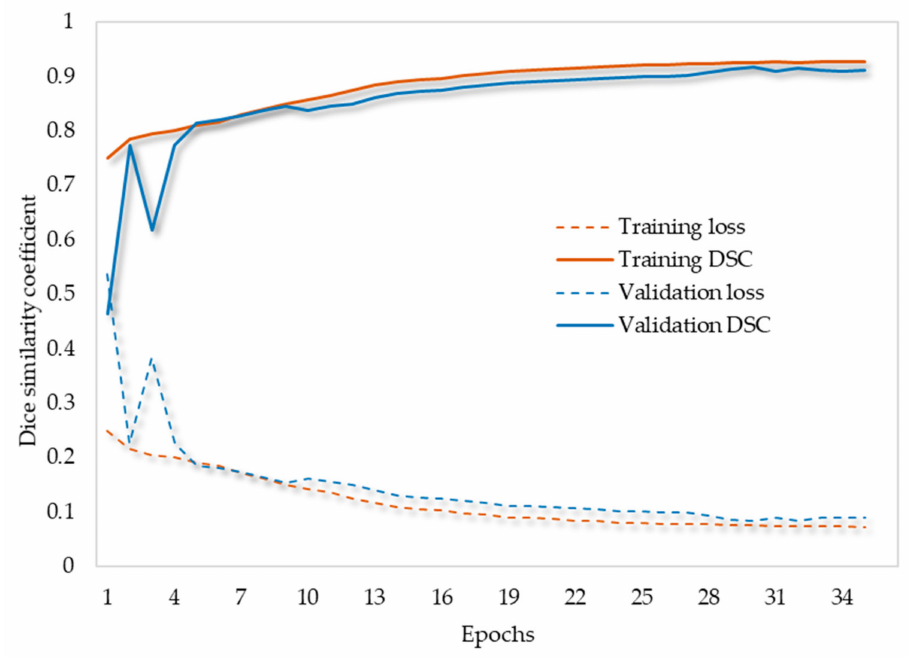
Figure 7. Metric evolution over epochs of the proposed